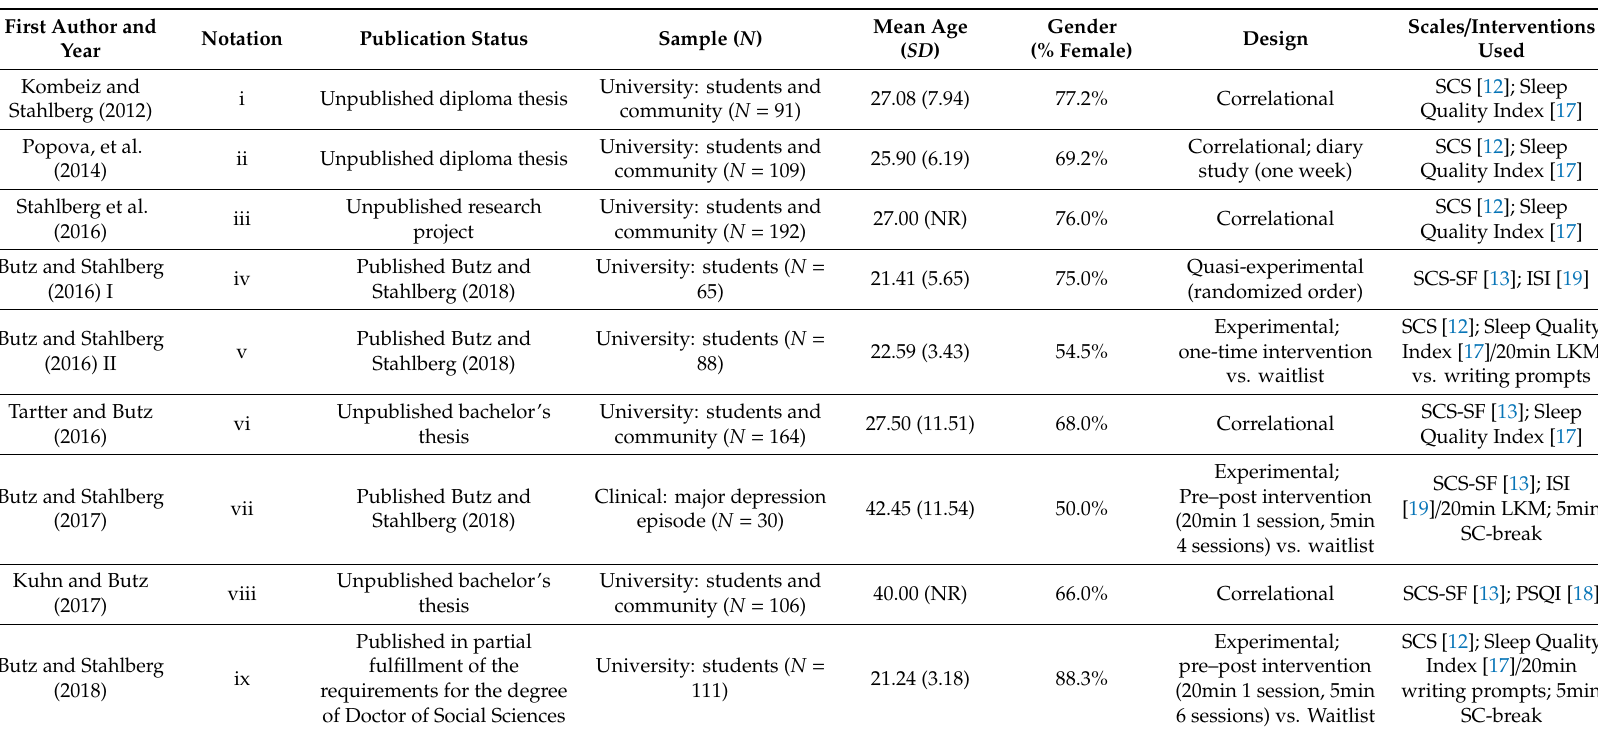
Table 1. Characteristics of studies examining the (causal) relationship between self-compassion and sleep quality. NR: not